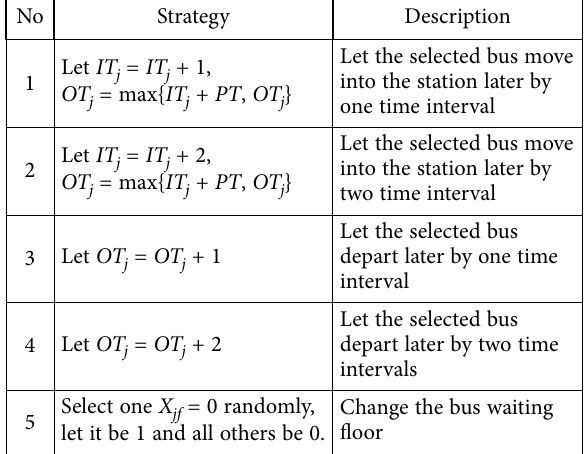
Figure 1. The procedure of the proposed methodology Table 1. Strategies for generating initial population of